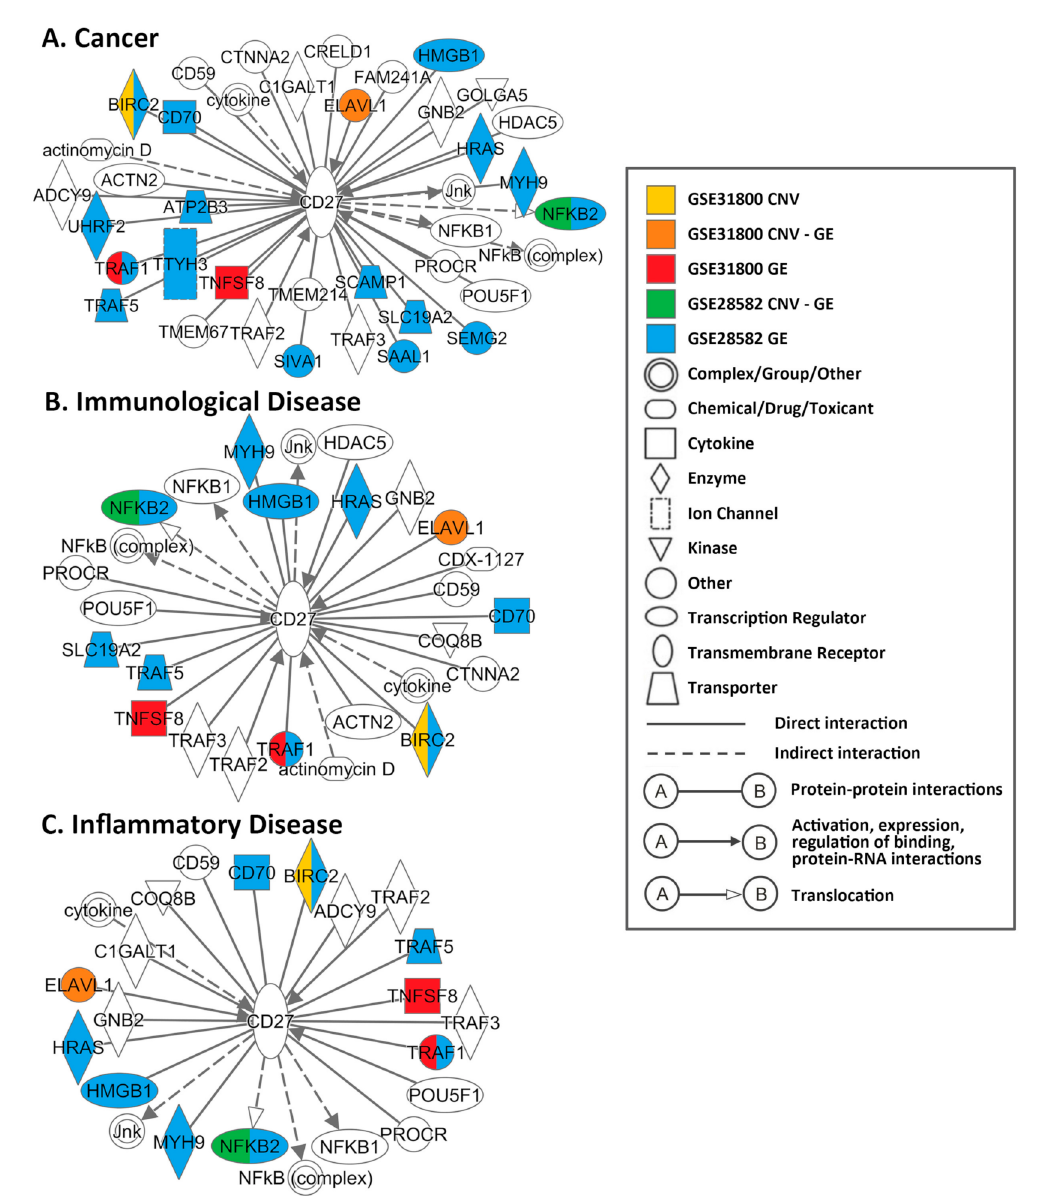
Figure 3. The experimentally confirmed interactions with CD27 retrieved from IPA. Functional involvements in ( A ) cancer- related interactions, ( B ) immunological disease-related interactions, and ( C ) inflammatory disease-related